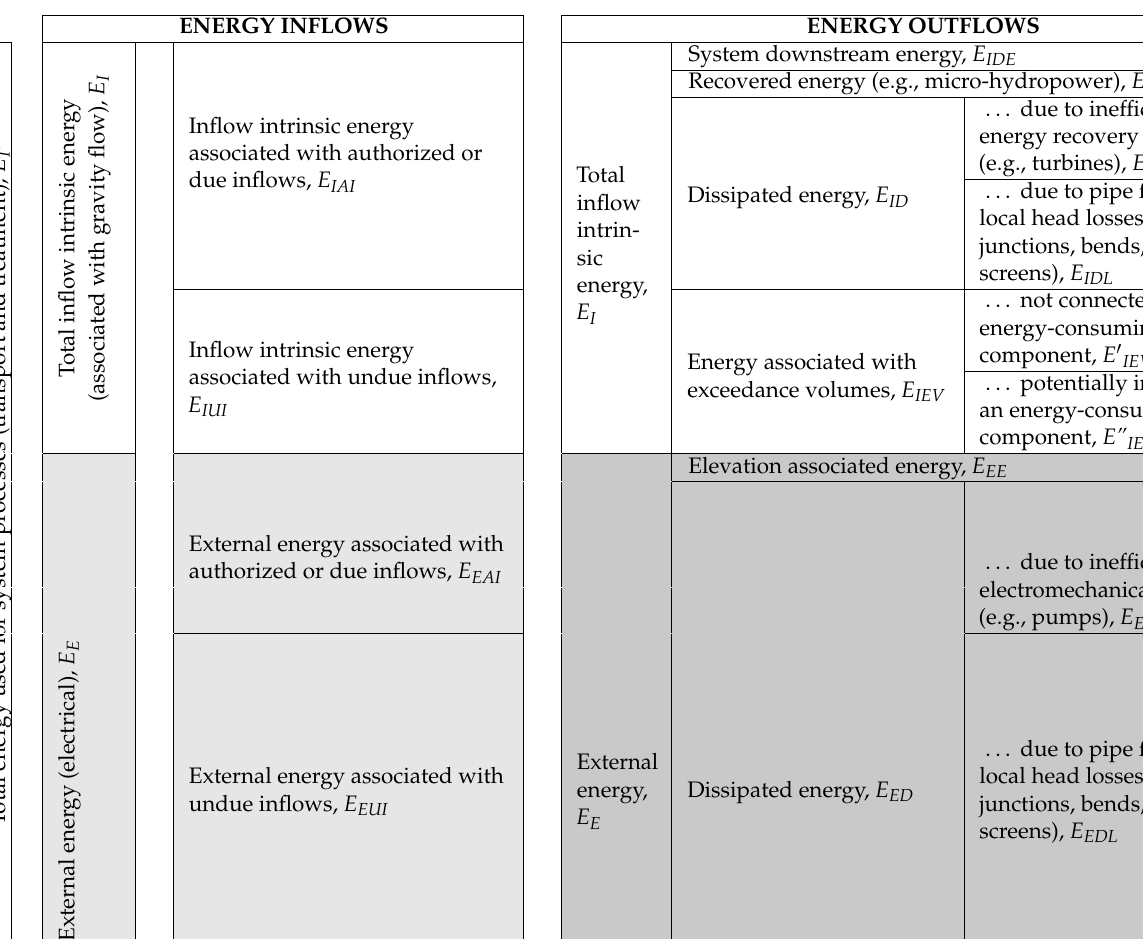
Table 1. Energy balance scheme for wastewater systems